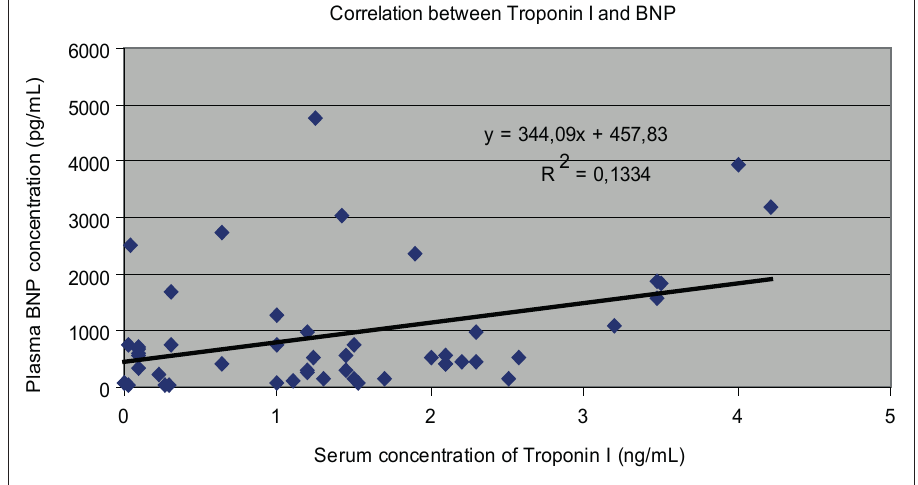
Figure 1. Comparison of TnI and BNP in blood measured by Architect CMIA correlation coefficient r =